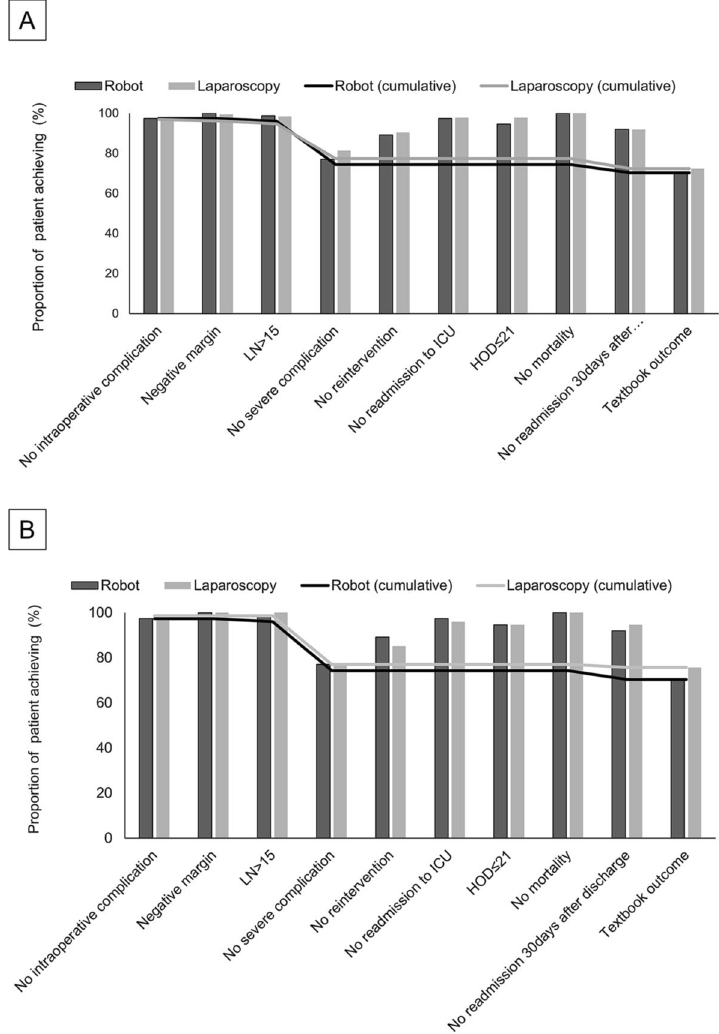
Figure 1. Proportion of patients achieving textbook outcome and each quality metric. ( A ) Entire cohort, ( B ) Matched cohort. LN lymph node, ICU intensive care unit, HOD hospital